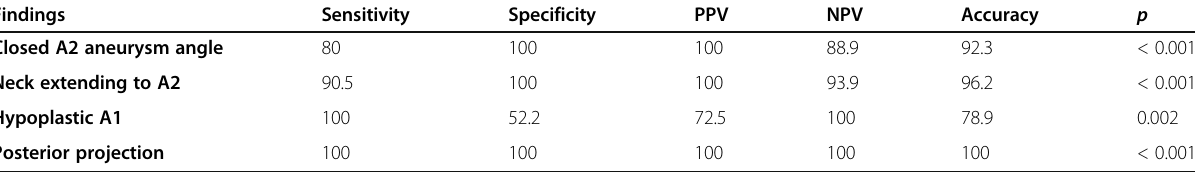
Table 2 Performance of CTA in diagnosis of lesions among the studied patients